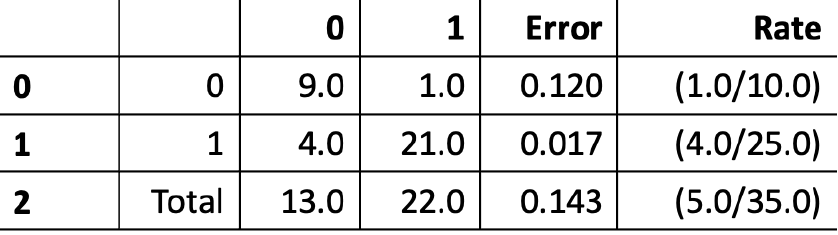
Figure 8. Results of confusion matrix for the prediction through the default random forest (DRF), which is the highest accuracy in used